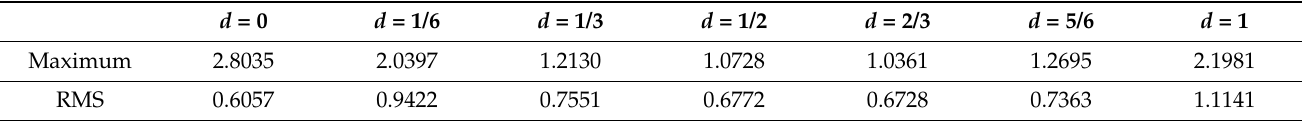
Table 5. Characterization of the acceleration spectra in the first ground profile